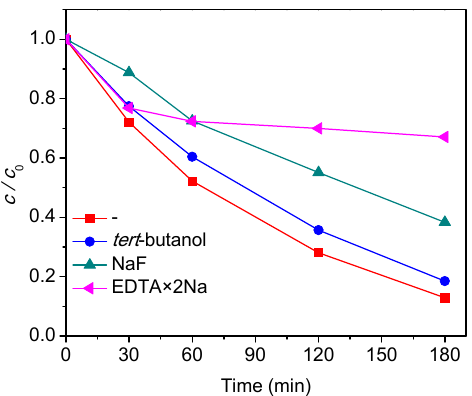
Figure 7. Effects of h + and ● OH scavengers (10 mM) on the efficiency of mesotrione (0.05 mM) photocatalytic degradation in the presence of 2.43 × 10 − 3 % Au–S–CH 2 –CH 2 –OH/TiO 2 (0.5 g/L) under simulated sunlight.